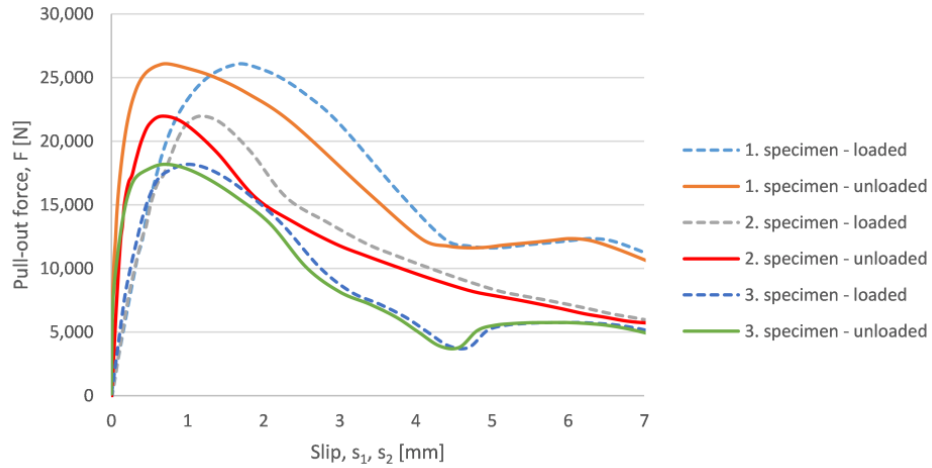
Figure 9. Results of the standard pull-out tests of NWAC.